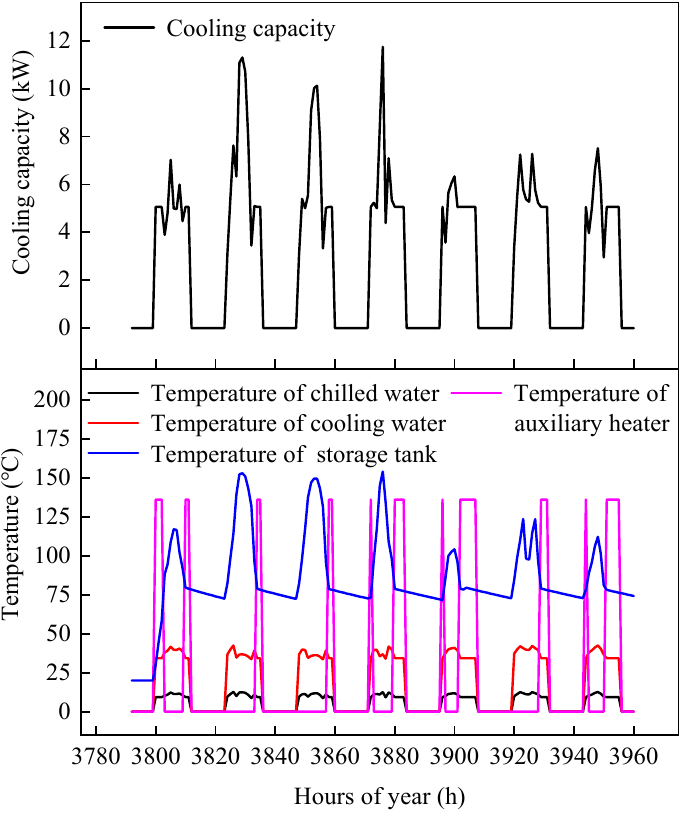
0.945. Because of the auxiliary heat source, the coefficient of performance was able to reach 4.54. The equivalent electric compression refrigeration performance coefficient was 10.09 (thermoelectric efficiency was 0.45). Figure 6. Dynamic condition of continuous operation of the system for one week.